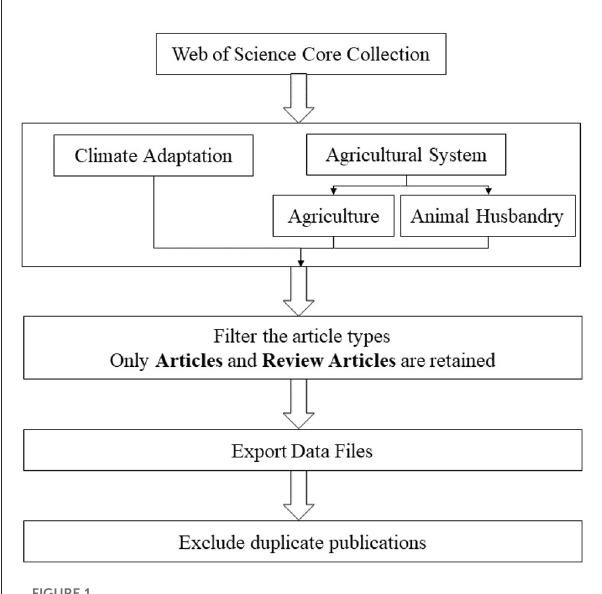
FIGURE1 The flow diagram of data selection.